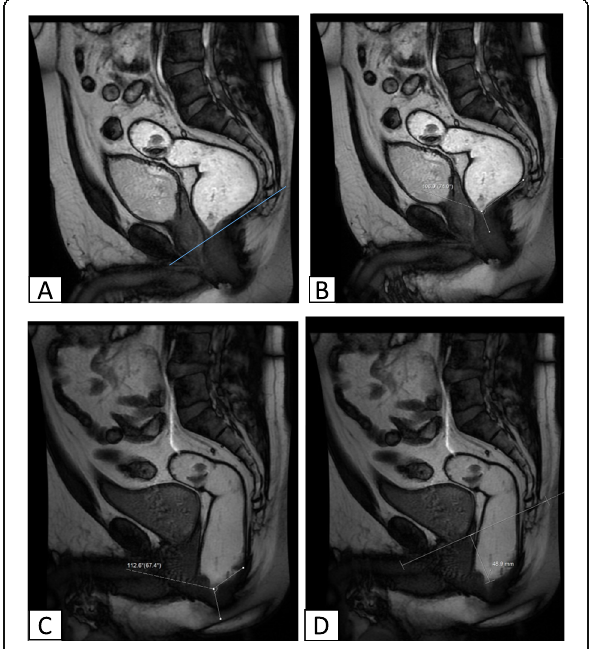
Fig. 7 Mid-sagital SSFP obtained ( a , b ) at rest and ( c , d ) during defecation showing at rest ano-rectal angle measuring 106°, c during defecation there is minimal increase in ano-rectal angle measuring 112 [< 10°] denoting failure of puborectalis to relax associated with ( d ) moderate rectal descent 4.8 cm